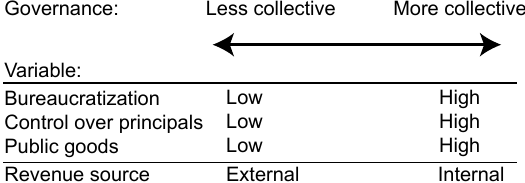
Fig. 7 Variability in